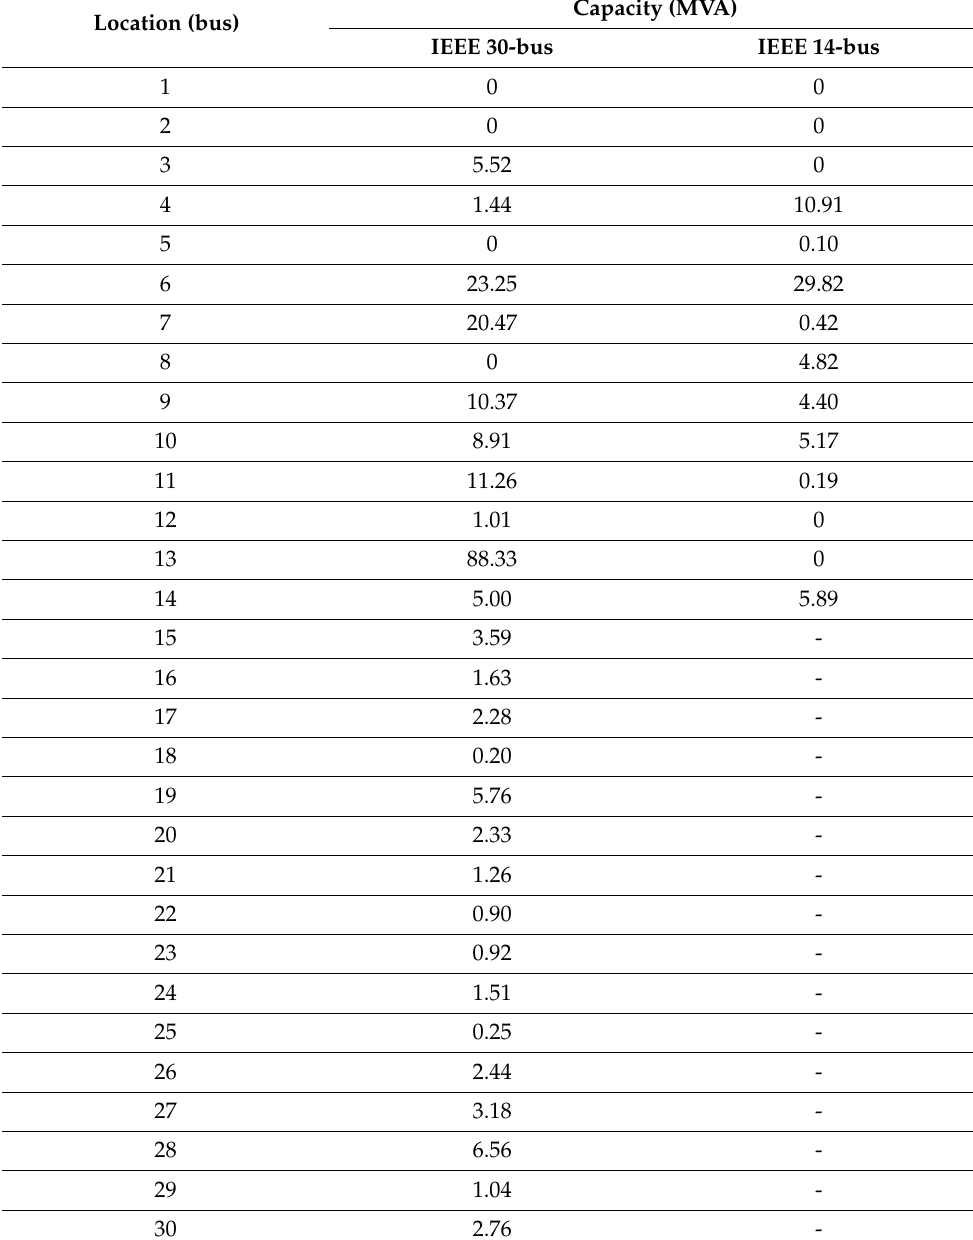
Table A1. Optimal location and capacity of DG